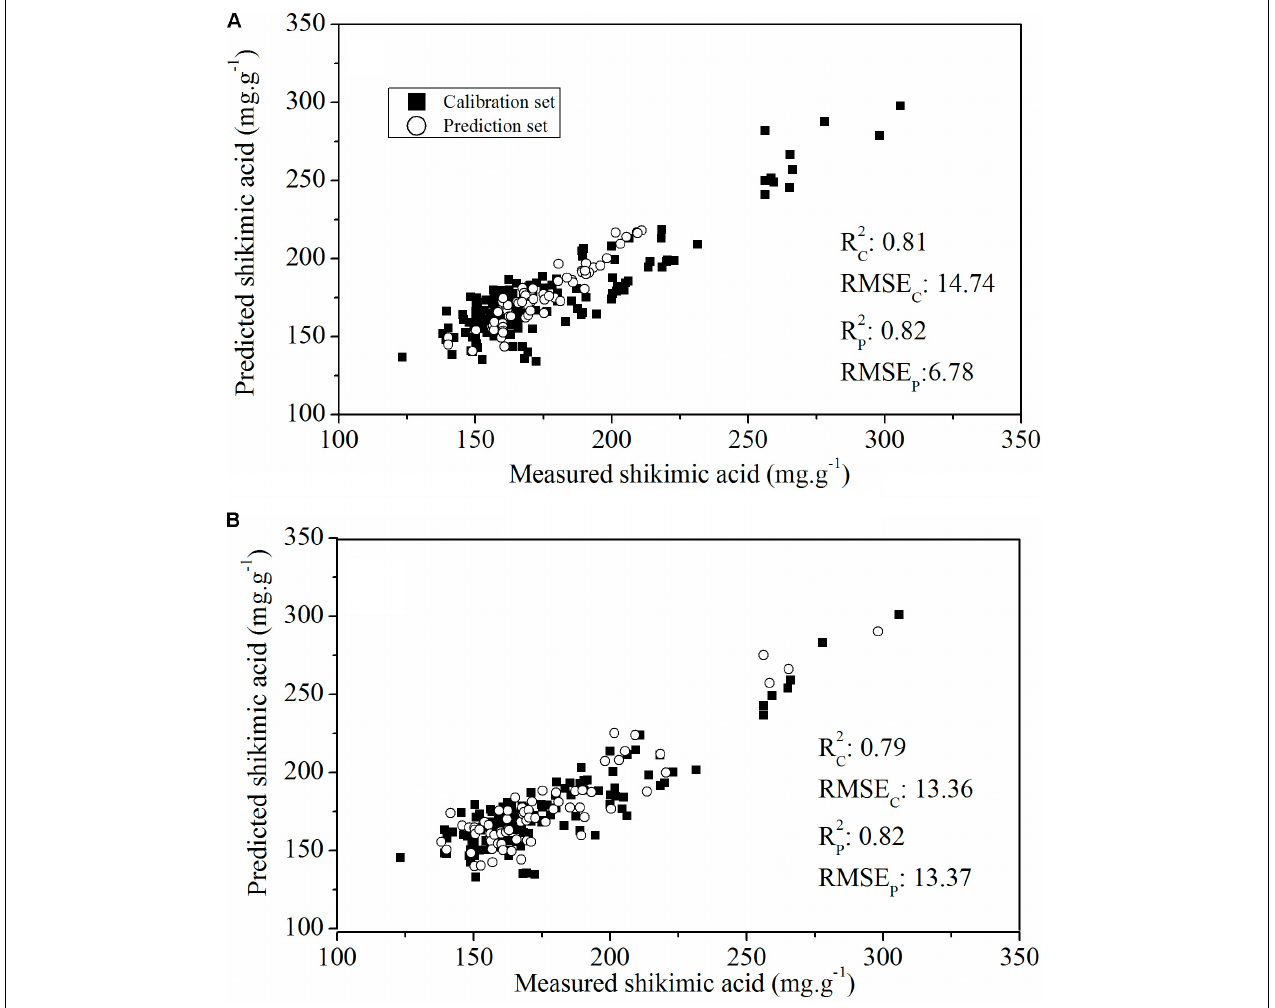
FIGURE 6 | Plot of reference vs. predicted values of shikimic acid concentration derived from the PLSR model based on the whole spectrum (A) or the sensitive wavelengths (B)